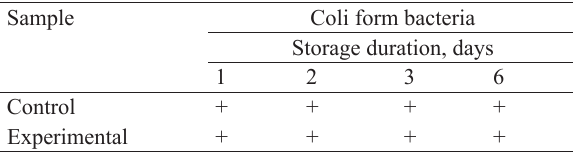
Table 11 Microbial contamination of carp during storage Sample